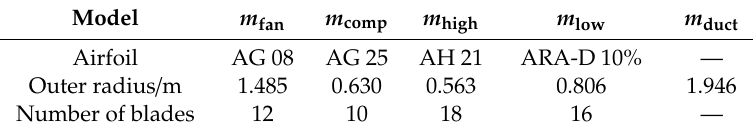
Table 1. Main geometric characteristics of the turbofan